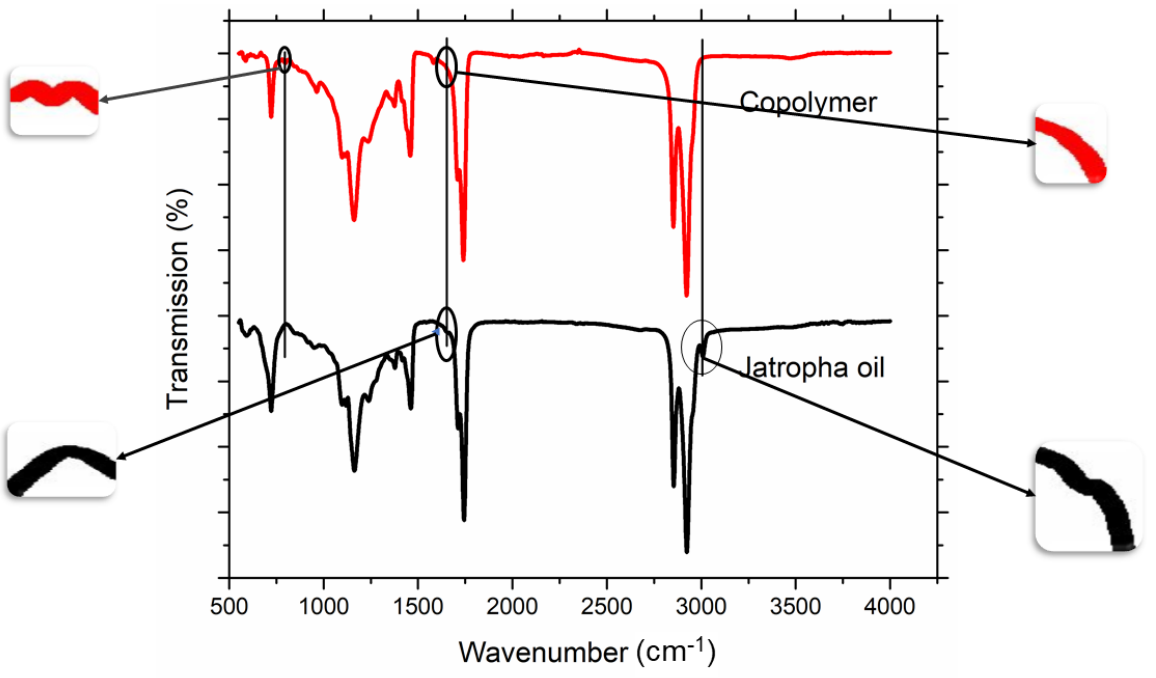
Figure 4. ATR–FTIR of the optimized